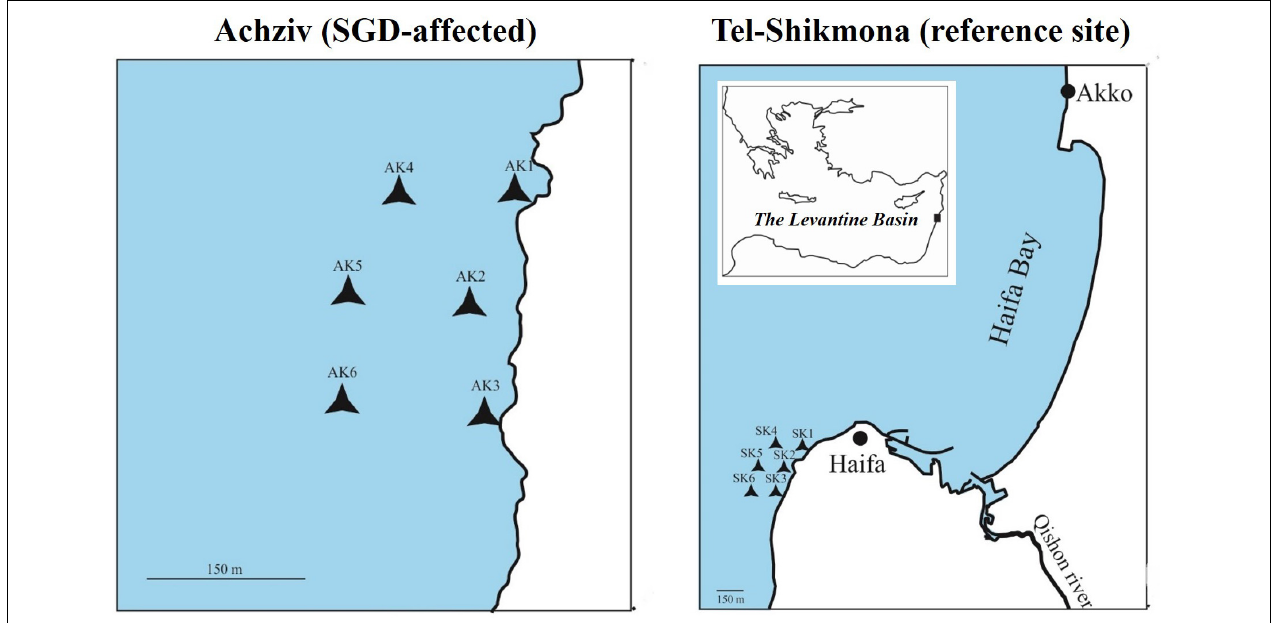
FIGURE 1 | Map showing the two sampling areas at the Israeli coastline in the SE Mediterranean Sea. In each site, 6 surface water samples were collected by diving. The Achziv sampling stations (left panel) are considered to be strongly influenced by nutrient inputs from SGD year round, and the Tel-Shikmona stations (right panel) are less influenced by SGD nutrient input throughout the annual cycle. Scale bars within the expanded regions are 150